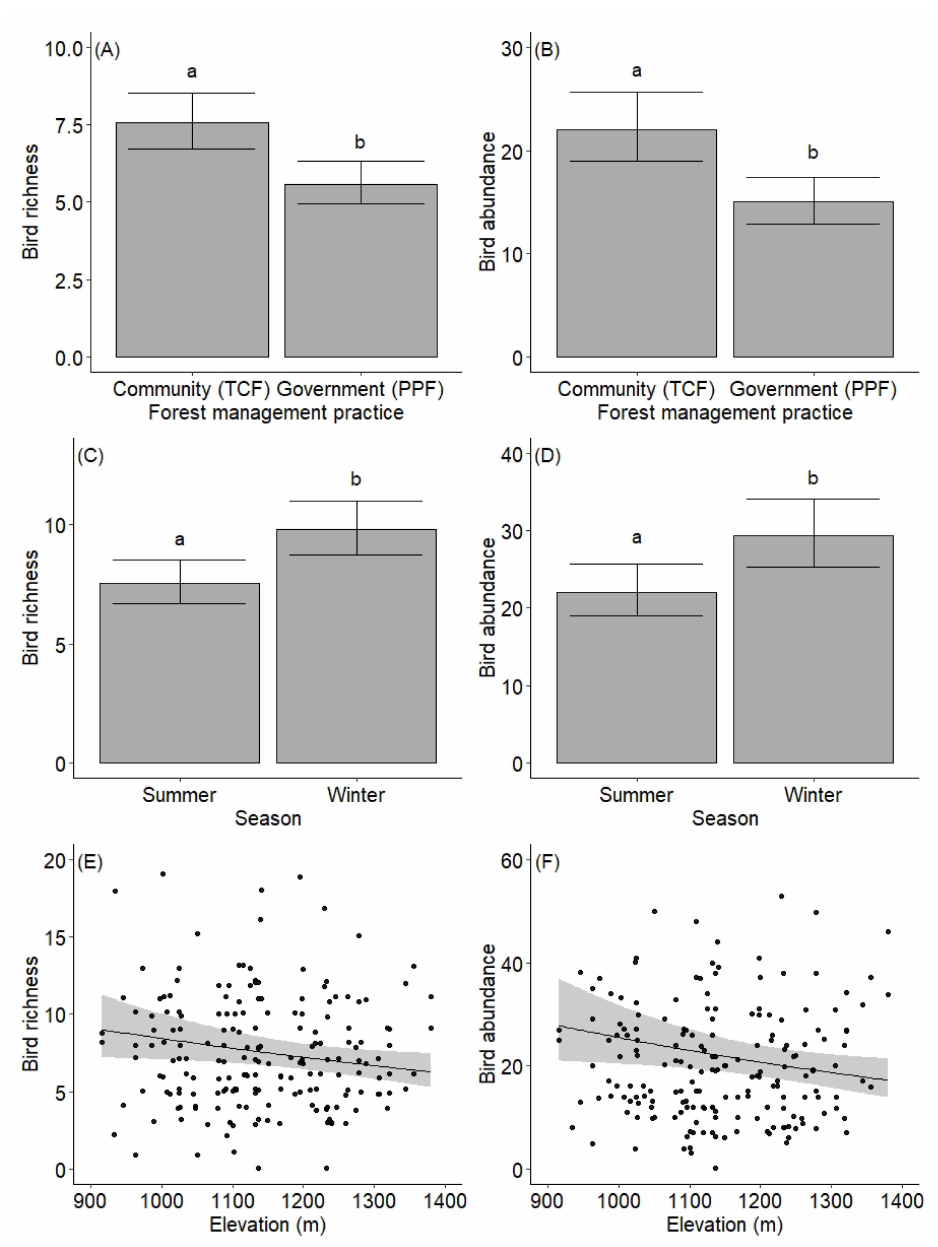
Figure 2. Predicted variation in species richness and abundance of birds by forest management practice ( A , B ), season ( C , D ) and elevational gradients ( E , F ) in the study area. The forest manage- ment practices are protected forest (Panchase Protection Forest), and community forest (Tibrekot Community Forest). The protected forest is managed by the government, while the community forest is managed by the community forest users’ group. ( A – D ) depict means ± 95% confidence intervals and different letters above the error bars denote significant differences between forest management